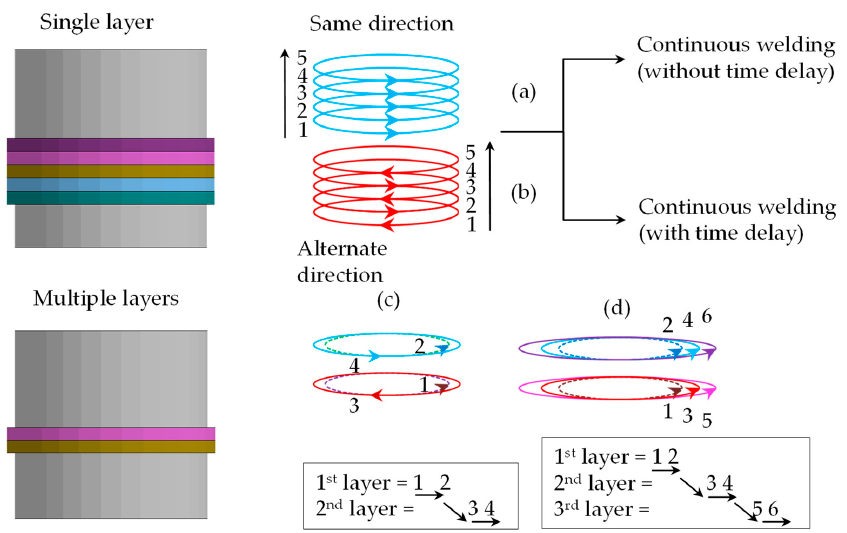
Figure 10. Welding trajectories for one-layer ( a , b ), two layers ( c ), and three layers ( d ) patterns. Dotted inner circles in Figure 10c,d represent the beads of the first layer, while the solid circles represent the beads of the second and third layers. The numbers above the arrows in Figure 10c,d show the welding sequence, i.e., the two parallel beads were welded in the first layer, followed by the welding of the next two beads in the second layer. Various welding trajectories of the 2 × 2 pattern can be seen in Figure 11.